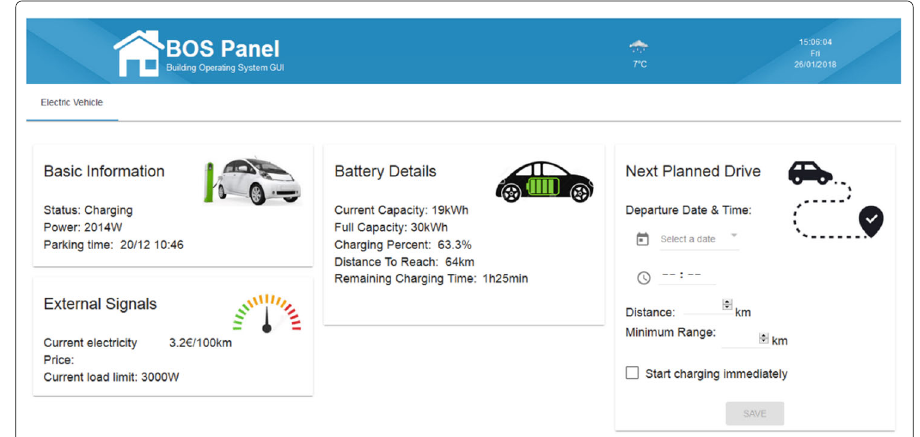
Fig. 21 BOS UI: the page of electric